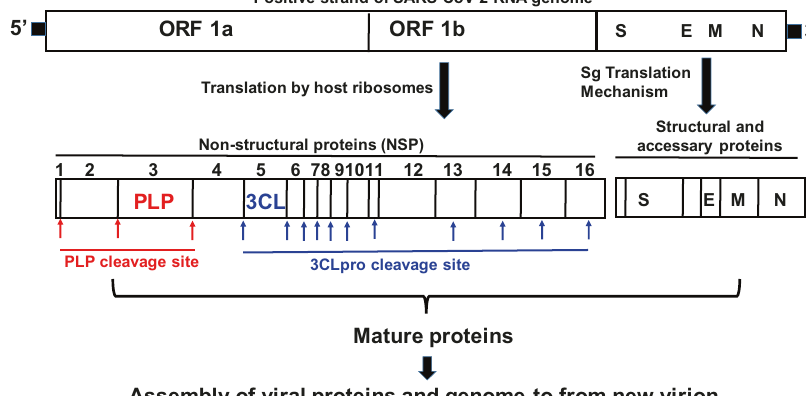
Fig. 1 Representation of SARS-CoV-2 genome arrangement and protease cleavage sites. Genetic material (RNA) of SARS-CoV-2 enters the host cell and borrows ribosome to translate into 16 nonstructural proteins upon auto-proteolytic cleavage by PLpro and 3CLpro enzymes. Structural proteins (S, E, M, and N) are translated by sg translation mechanism. All mature proteins assemble along with positive-sense single stranded RNA genome to form new virion. Arrows indicates the protease cleavage sites. ORF open reading frame, PLP papain like protease, 3CLP 3-chymotrypsin like protease, S spike protein, E envelop protein, M membrane protein, N